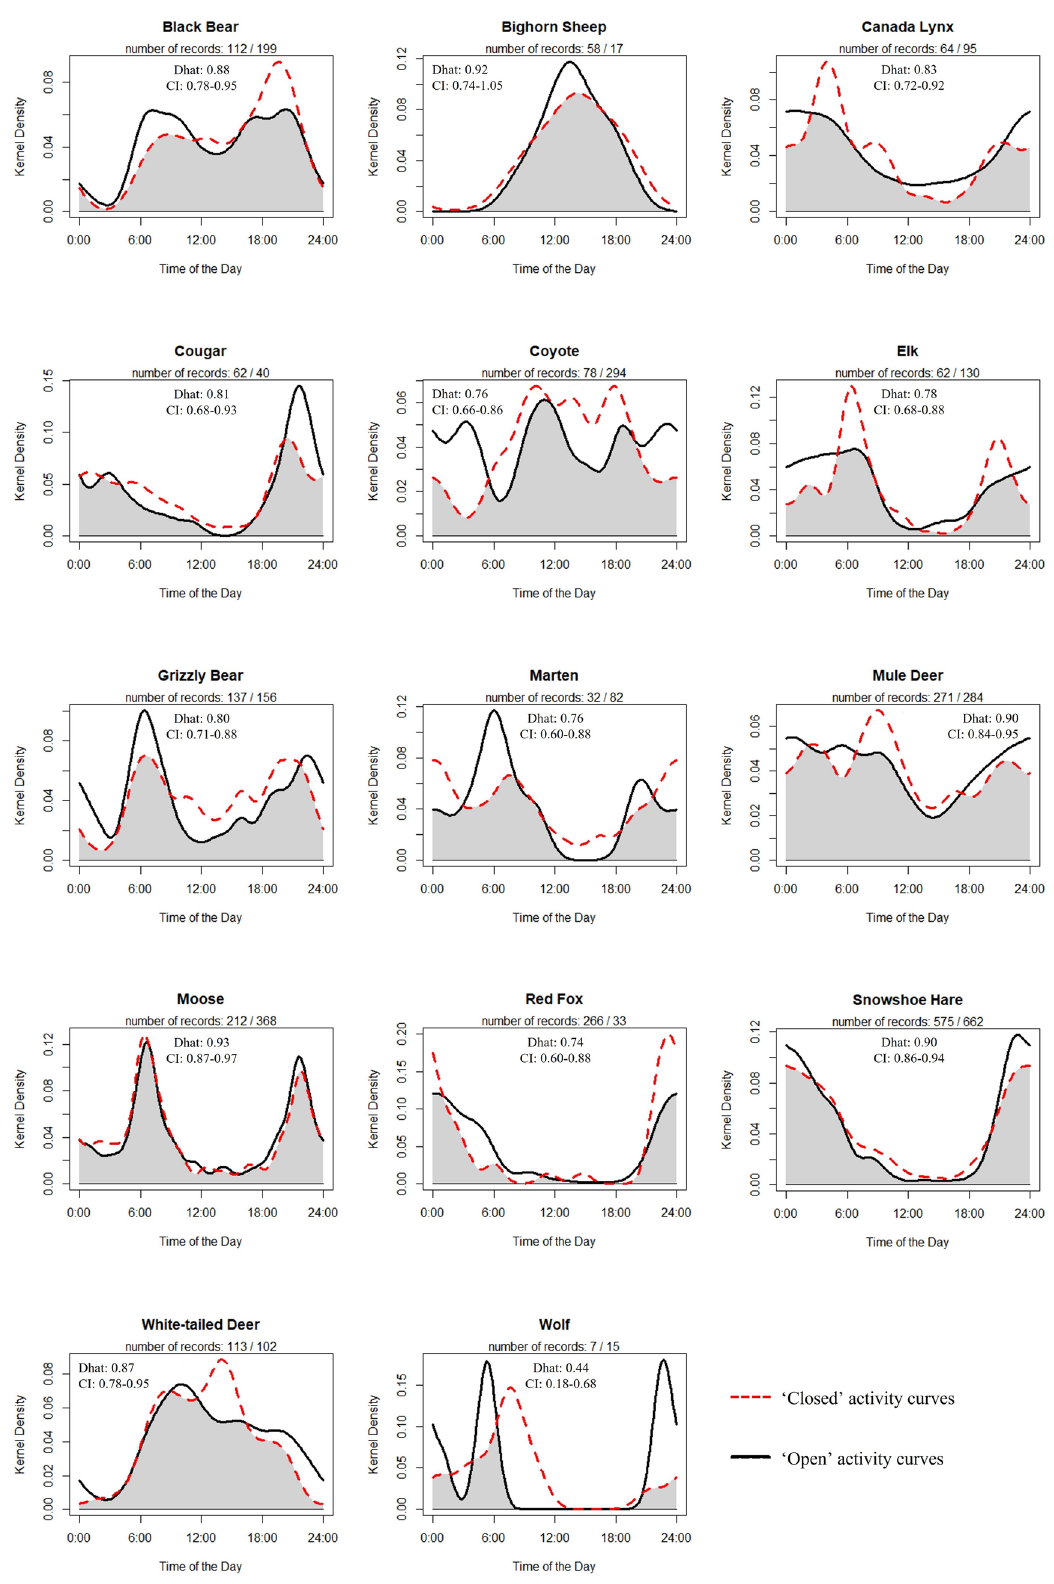
Figure 3. Daily activity overlap of each species between the year open and closed to human recreation. Dhat values represent the amount of overlap between the activity curves, with 0 representing complete separation and 1 representing complete overlap (95% CIs obtained via